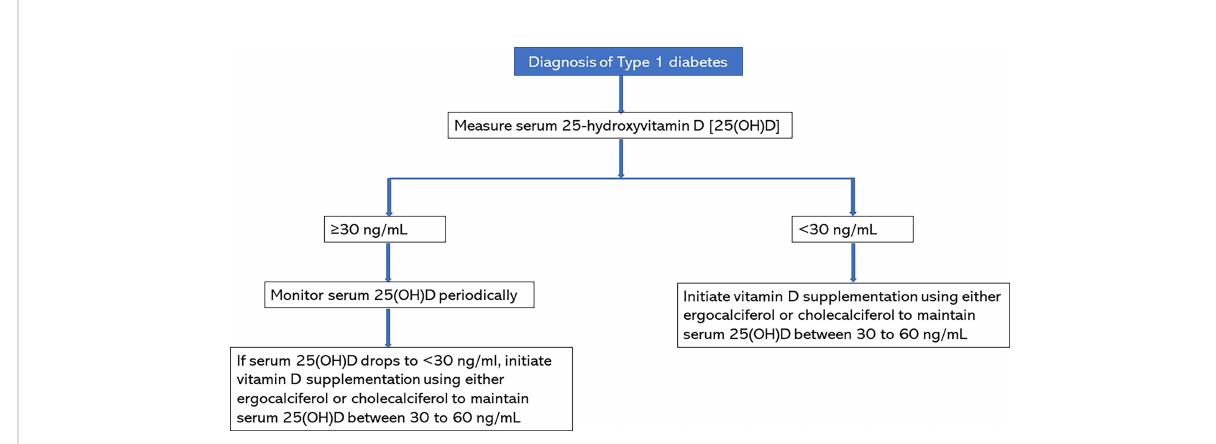
FIGURE 1 Protocol for vitamin D supplementation in patients with new-onset type 1